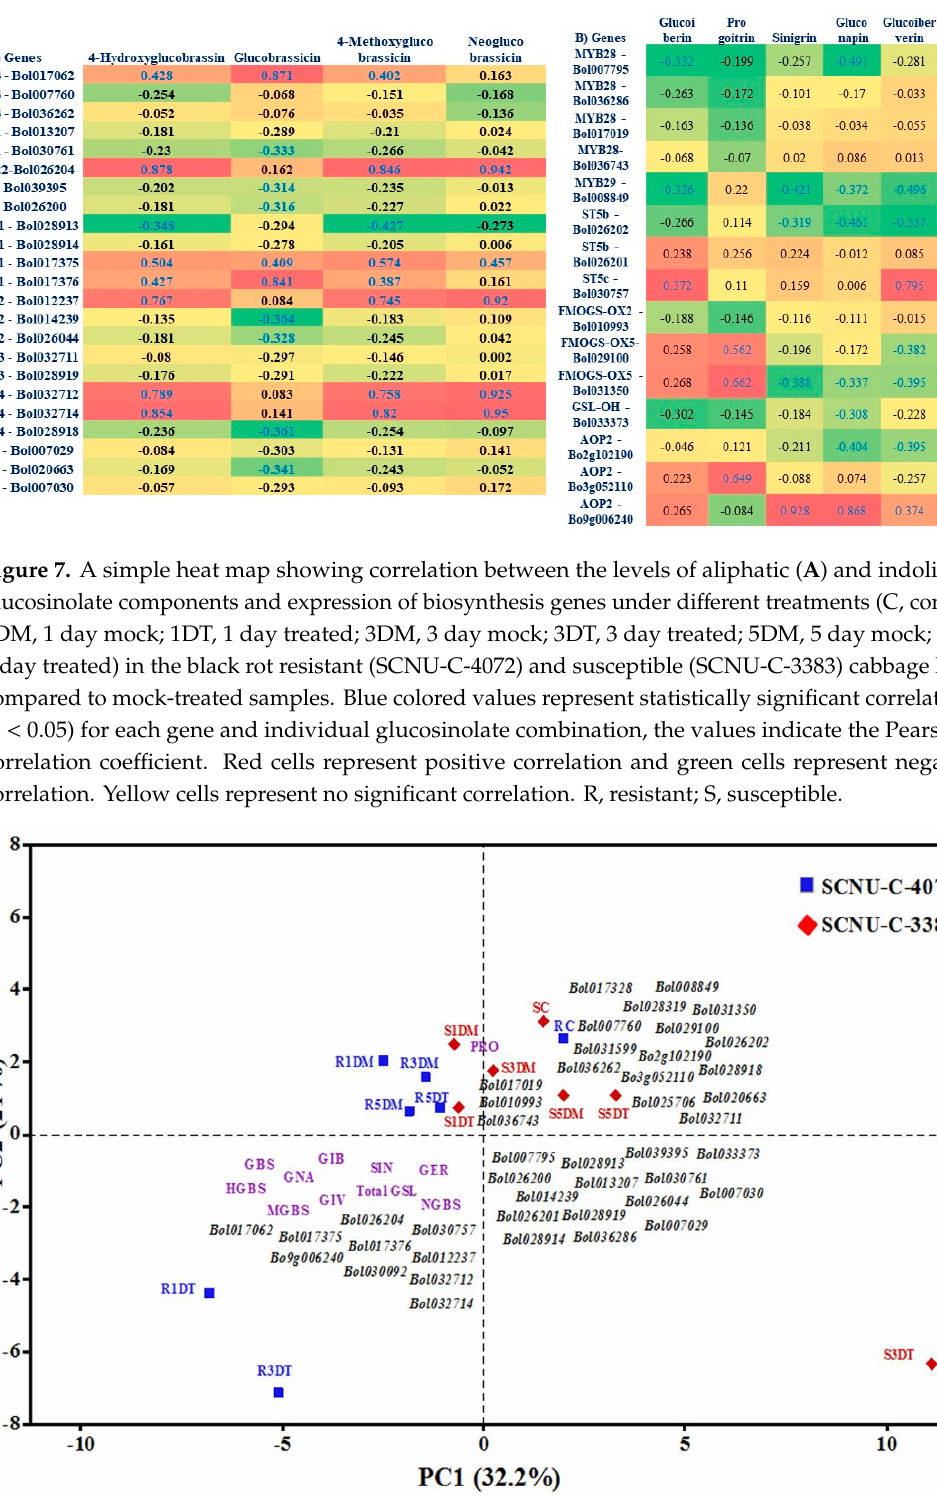
Figure 8. Biplot of black rot R and S cabbage lines, glucosinolate (GSL) compounds (pink color), and responses of GSL biosynthesis and breakdown related genes (black color) as determined by principle component analysis (PCA). Dark blue squares denote the mean PC scores of the R (SCNU-C-4072) line, and red diamond symbol indicate the mean PC scores of the S (SCNU-3383) line. X. campestris pv. campestris treatments denoted by C, control; 1DM, 1 day mock; 1DT, 1 day treated; 3DM, 3 day mock; 3DT, 3 day treated; 5DM, 5 day mock; 5DT, 5